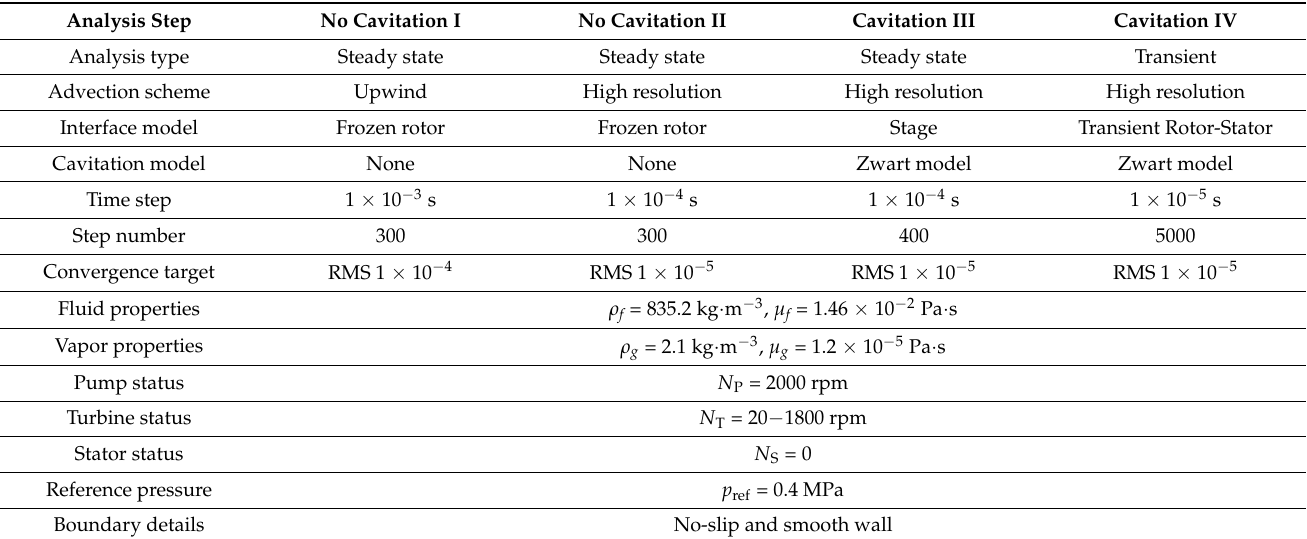
Table 4. Detailed setting of torque converter CFD